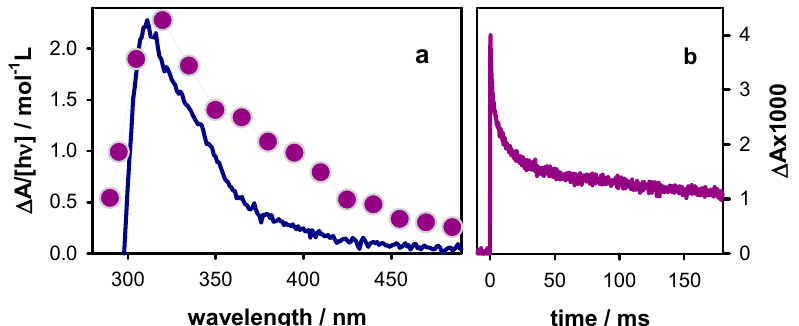
Figure 9. ( a ) Steady-state (blue line) and time-resolved (violet circles; 30 ms; intensity divided by 7) differential absorption spectra determined for TEL21/K + ; the steady-state spectrum was obtained by subtracting the absorption spectrum recorded after irradiation with 266 nm pulses from that recorded before irradiation. [h ν ] is the total concentration of absorbed photons in the probed volume. ( b ) Transient absorption trace at 365 nm recorded with incident excitation intensity of 2 × 10 6 Wcm − 2 .